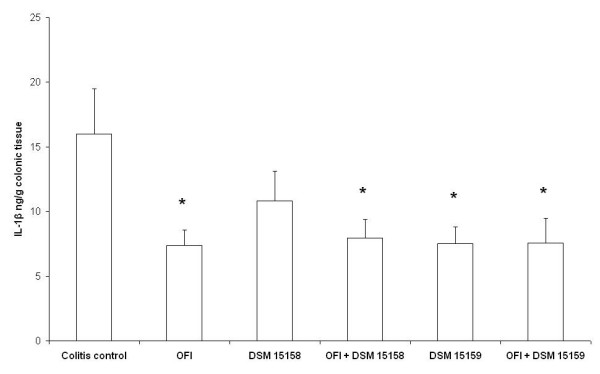
Colonic IL-1β values (pg/g tissue). * denotes p < 0.05 compared to colitis control.